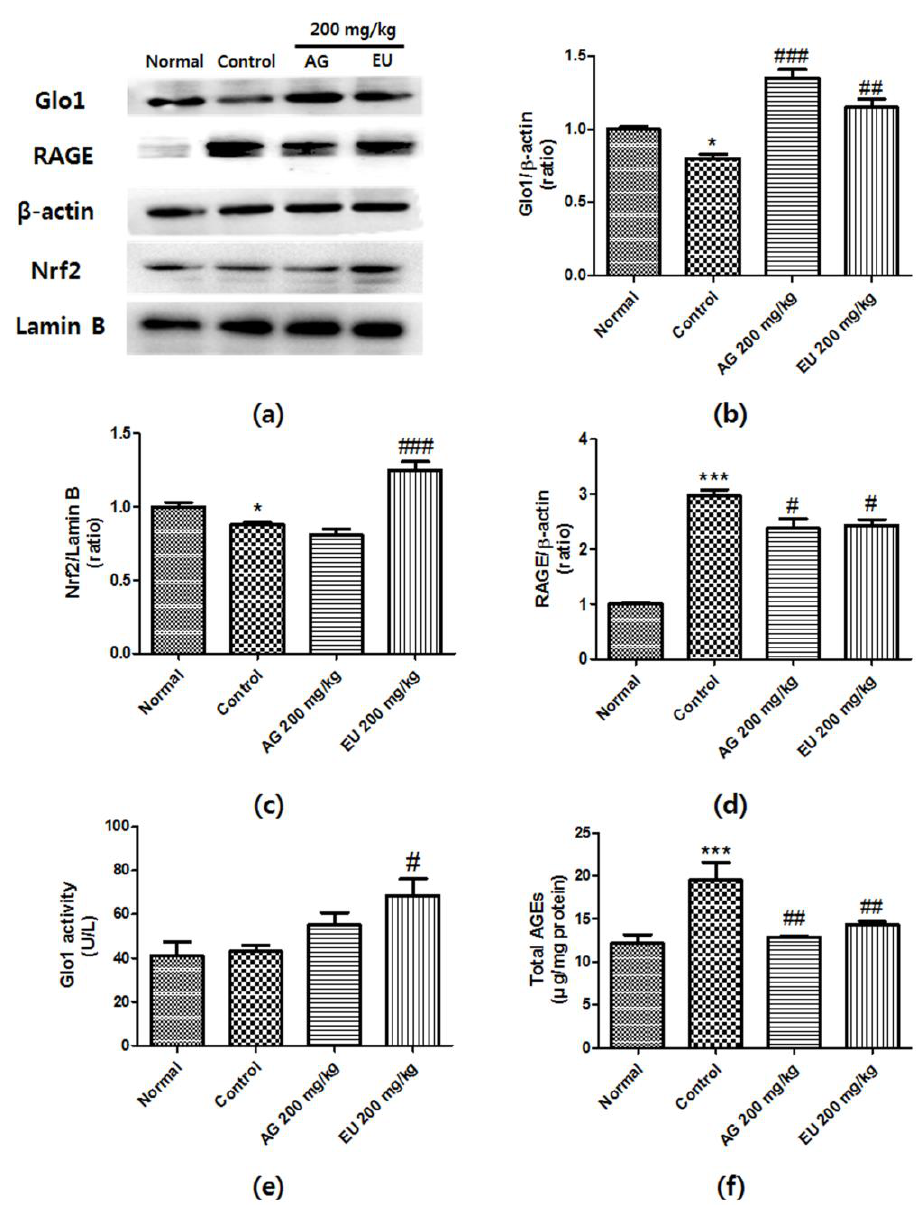
Figure 4. The effects of Eucommia ulmoides Oliv. (EU) on the expression of glyoxalase 1 (Glo1), receptors of advanced glycation end-product (RAGE), and nuclear factor erythroid 2-related factor 2 (Nrf2), and Glo1 activity. ( a ) Representative western blots of Glo1 are shown. β -Actin and lamin-B were used as internal controls. Relative band intensities of ( b ) Glo1; ( c ) RAGE; and ( d ) and nuclear Nrf2. The experiments were repeated three times, and one representative blot is shown. ( e ) GLO-1 activity of STZ-induced diabetic mouse kidney tissue was determined by measuring the formation of S - D -lactoylglutathione; ( f ) Total AGE levels in mouse kidneys were measured using enzyme-linked immunosorbent assay (ELISA) of AGEs-protein adducts. Values are means ± standard deviation (SD) of three independent experiments; (* p < 0.05 and *** p < 0.001 vs. normal; # p < 0.05, ## p < 0.01, and ### p < 0.001 vs. control).